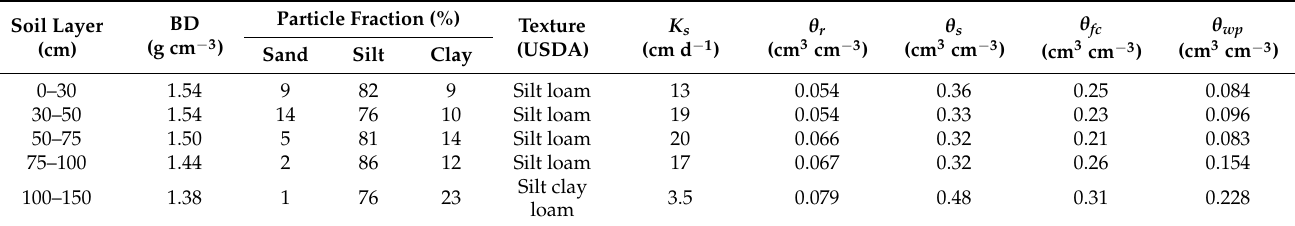
Table 1. Soil texture and hydraulic properties of the soil profile in the experiment